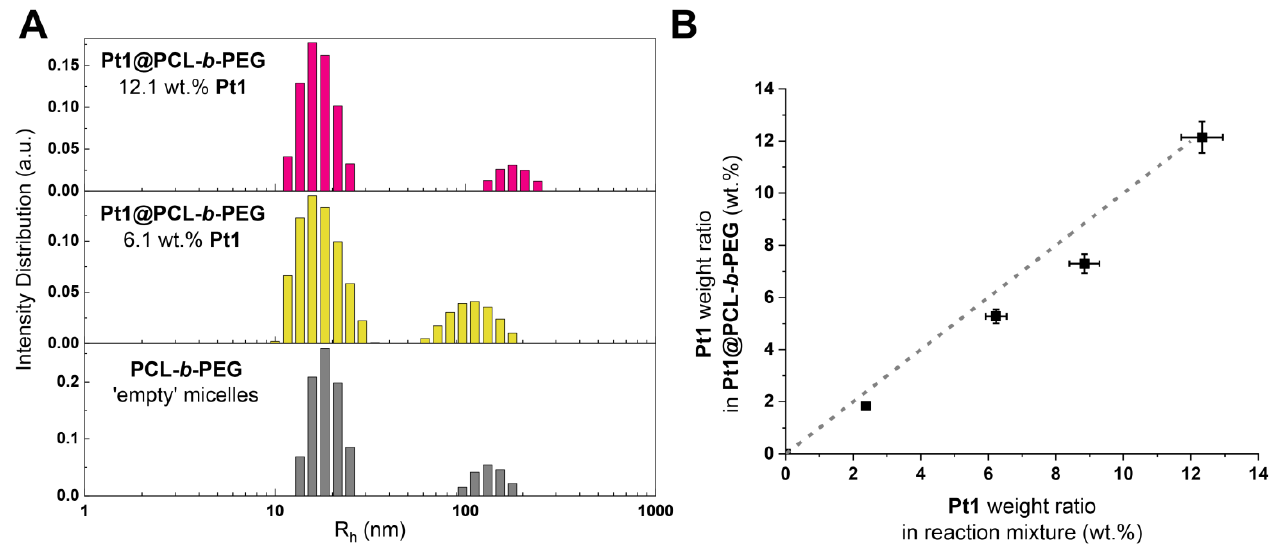
Figure 1. ( A ). Intensity weighted R h distributions of ‘empty’ PCL- b -PEG (grey) and ‘loaded’ Pt1@PCL- b -PEG (6.1 (yellow) and 12.1 (red) wt.% Pt1 ) micelles measured at 90°. C = 0.25 mg/mL. ( B ). Dependence of Pt1 weight ratio in Pt1@PCL- b -PEG block copolymer micelles as a function of Pt1 weight ratio in reaction mixture (black squares). Dashed line denotes theoretical dependence corresponding to 100% loading efficiency.